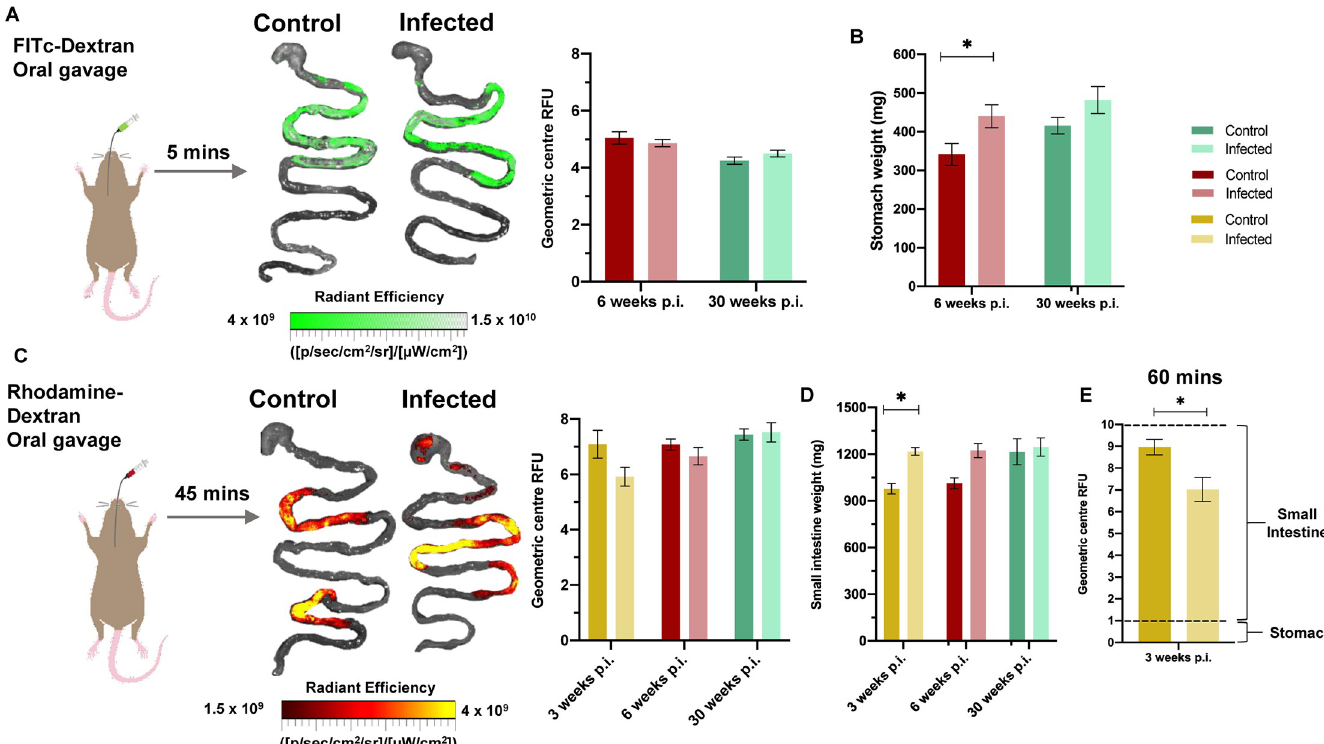
Fig 3. Fluorescent tracer imaging assays for stomach emptying and small intestine transit. A. Schematic diagram of a mouse receiving oral gavage of a green fluorescent marker, FITc-conjugated 70 kDa dextran, 5 minutes prior to termination to trace stomach emptying delay during infection. Representative images of stomach and small intestine are superimposed with traces of FITc-dextran travelling through stomach into small intestine to show transit difference between control and TcI-JR C3H/HeN infected mice. Linear-scale pseudocolour heat map shows minimum and maximum fluorescence intensity of 70-kDa FITC-dextran. Quantification of FITC-dextran fluorescence in control na ï ve and TcI-JR C3H/HeN is shown in the adjacent bar plot at 6 ( n = 12 per group) and 30 ( n = 5 per group) weeks post-infection (p.i.). Fluorescence is expressed as geometric centre which is centre mass of the marker. B. Bar plot shows post-mortem weights of stomach with contents at 6 ( n = 7 per group) and 30 ( n = 5 per group) weeks p.i. C. Similar schematic diagram and bar plot at 3 ( n = 4 per group), 6 ( n = 4 per group) and 30 ( n = 5 per group) weeks p.i. using a red fluorescent marker, rhodamine-dextran, to target small intestine transit. Linear-scale pseudocolor heat map shows minimum and maximum fluorescence intensity of rhodamine-dextran. D. Small intestine weights shown in bar plot at 3 ( n = 4 per group), 6 ( n = 7 per group) and 30 ( n = 5 per group) weeks p.i. E. Bar plot shows quantification of rhodamine-dextran fluorescence administered 60 minutes before termination of mice at 3 weeks p.i. ( n = 4 per group). Dashed lines on bar plots show the GI segment number corresponding to the geometric centre score (0–1 = stomach, 1–10 = small intestine, proximal to distal). Data are expressed as mean ± SEM. Statistical significance was tested using unpaired two-tailed Student’s t test ( � P < 0.05).